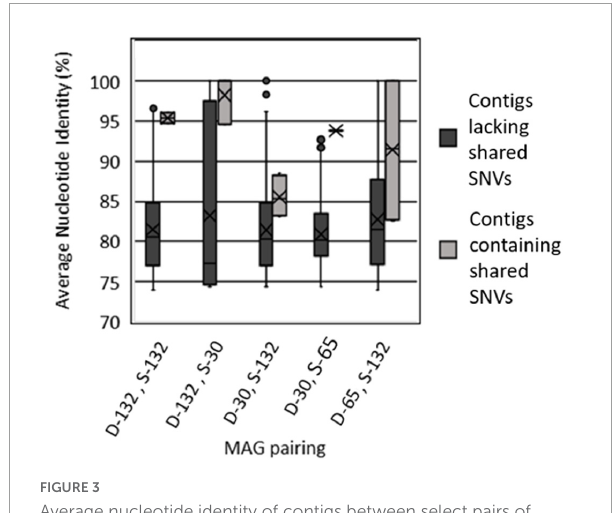
FIGURE3 Average nucleotide identity of contigs between select pairs of metagenome assembled genomes (MAGs) that contain shared single nucleotide variants (SNVs) versus contigs from those pairs of MAGs that lack shared SNVs. MAGs are labeled as belonging to the Type I surface phylogenetic clade (S) or the Type II deep phylogenetic clade (D) followed by the maximum depth interval (m) from where they were recovered (30, 65, 132). Values for all MAG pairings are reported in Table 3